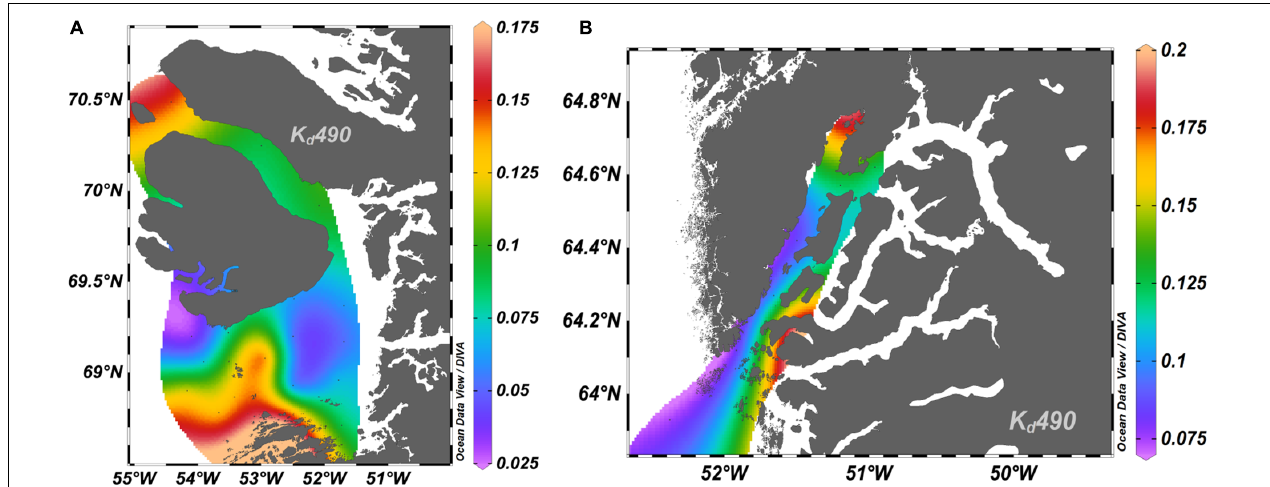
FIGURE 7 | Diffuse attenuation coefficient (K d 490). Surface distribution maps of K d 490 in the Vaigat-Disko Bay (A) and in Godthabsfjord (B) .